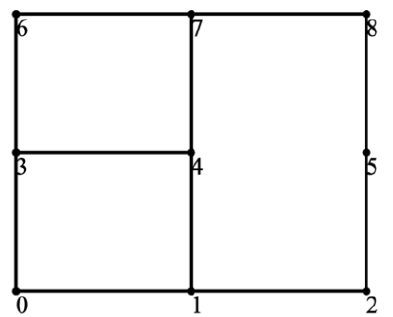
Figure 9. Most efficient graph for 3 × 3 lattice converter from node 0 to node 6.